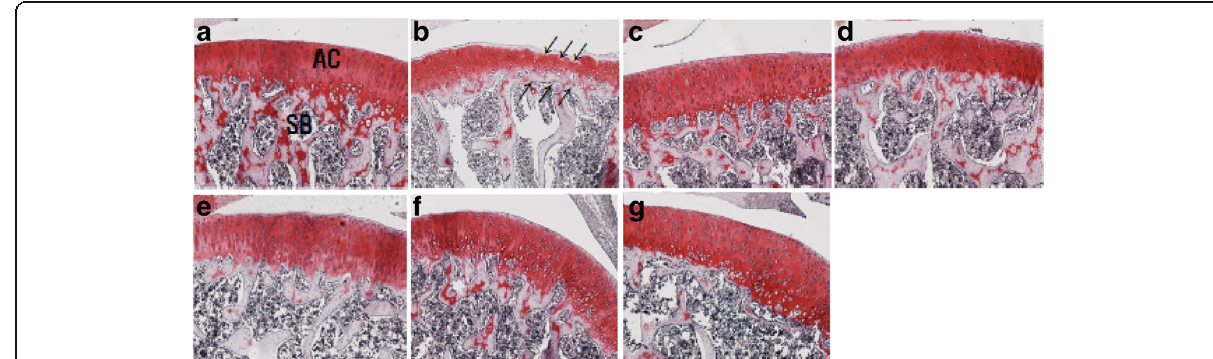
Fig. 4 Histopathological changes (Safranin O-fast staining) in the knee joint after ChondroT administration in collagenase-induced arthritis rats. Safranin O-fast staining showed a clear reaction of proteoglycans in ChondroT200 group. Safranin O-fast stain, Scale bars = 100 μ m. a Intact, b Control, c Indomethacin, d Joins Tab, e ChondroT50, f ChondroT100, g